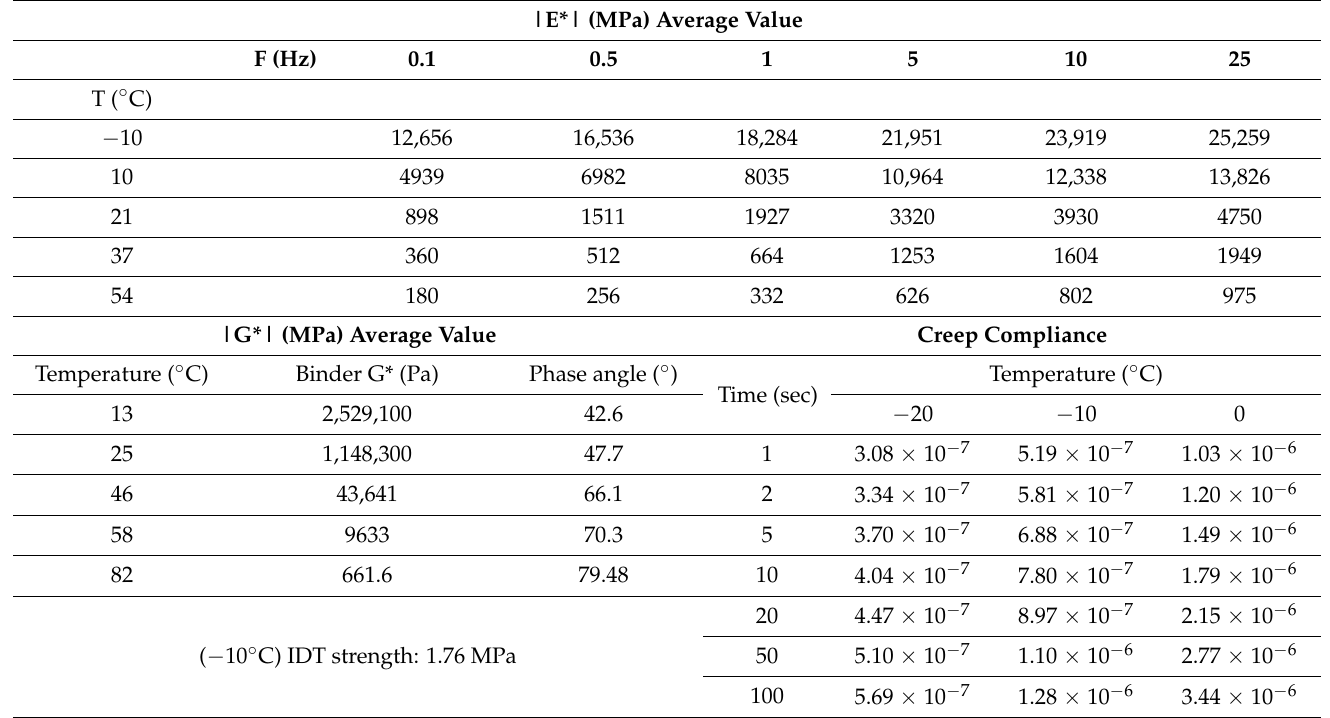
Table 6. Pavement M-E input for 12.5